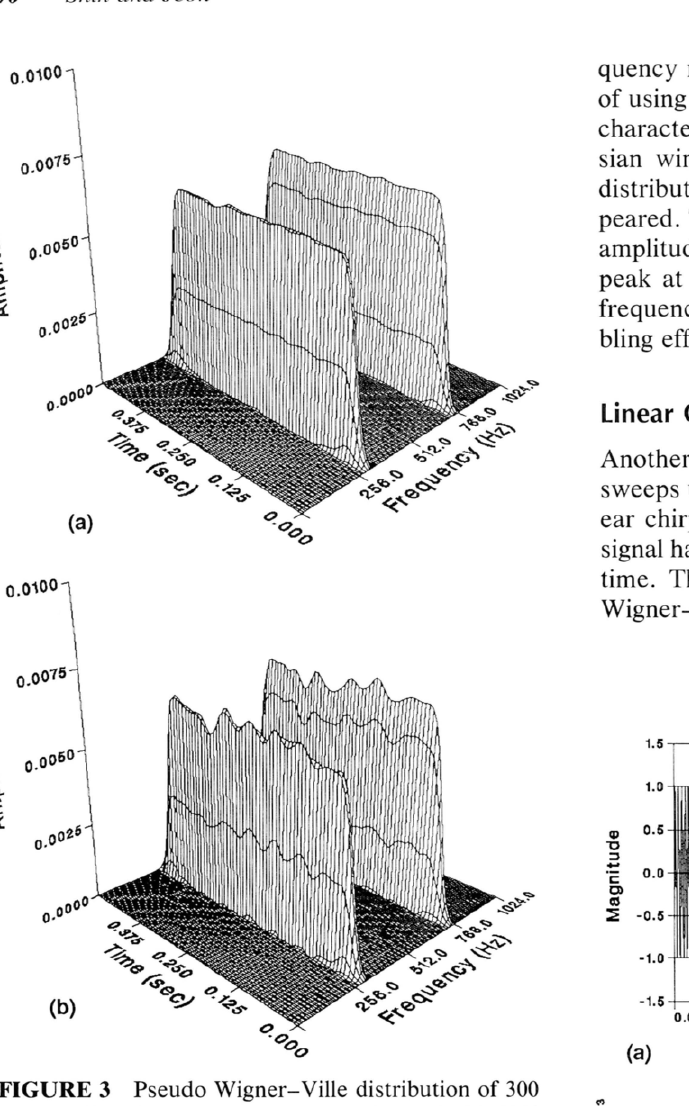
FIGURE 3 Pseudo Wigner-Ville distribution of 300 and 750 Hz sine waves; signal to noise ratio (a) 10% and (b) 50%. Is = 2048 Hz, N = 1024, and smoothing window size = 18 x 18.